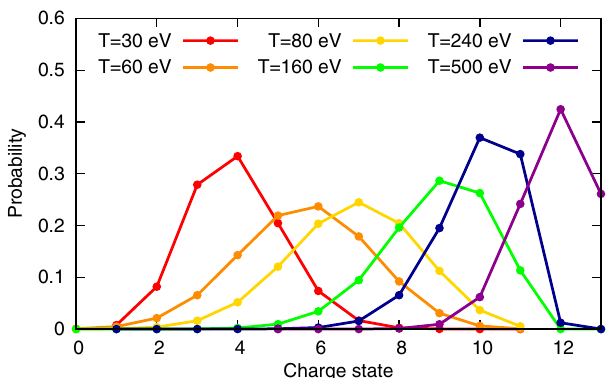
FIG. 3. Probability distribution of charge states for different temperatures calculated in the first step of our two-step HFS